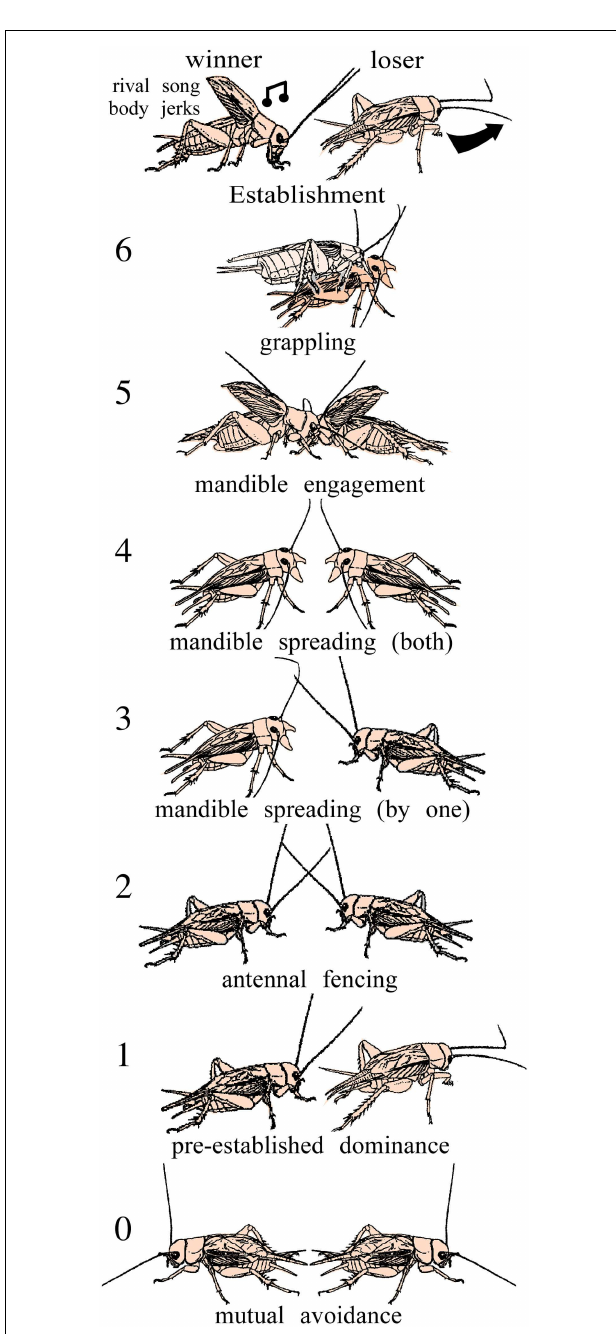
FIGURE 2 | Stereotyped levels of escalating aggression shown by male adult crickets. Level 0 mutual avoidance: no aggressive interaction. Level 1 pre-established dominance: one cricket attacks, the other retreats. Level 2 antennal fencing. Level 3 mandible spreading (by one): one cricket displays spread mandibles. Level 4 mandible spreading (both): both crickets display spread mandibles. Level 5 mandible engagement: the mandibles interlock and the animals push against each other. Level 6 grappling: an all out fight, the animals may disengage, and reengage to bite other body parts. Establishment: the fight can be concluded at any level by one opponent, the loser, retreating, the established winner typically produces the rival song and body jerking movements (modified from Stevenson et al., 2000; Stevenson et al.,